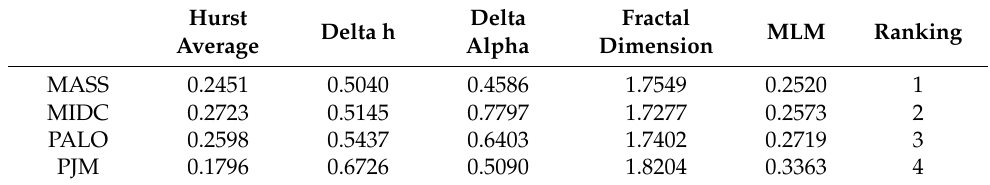
Table 4. Results of